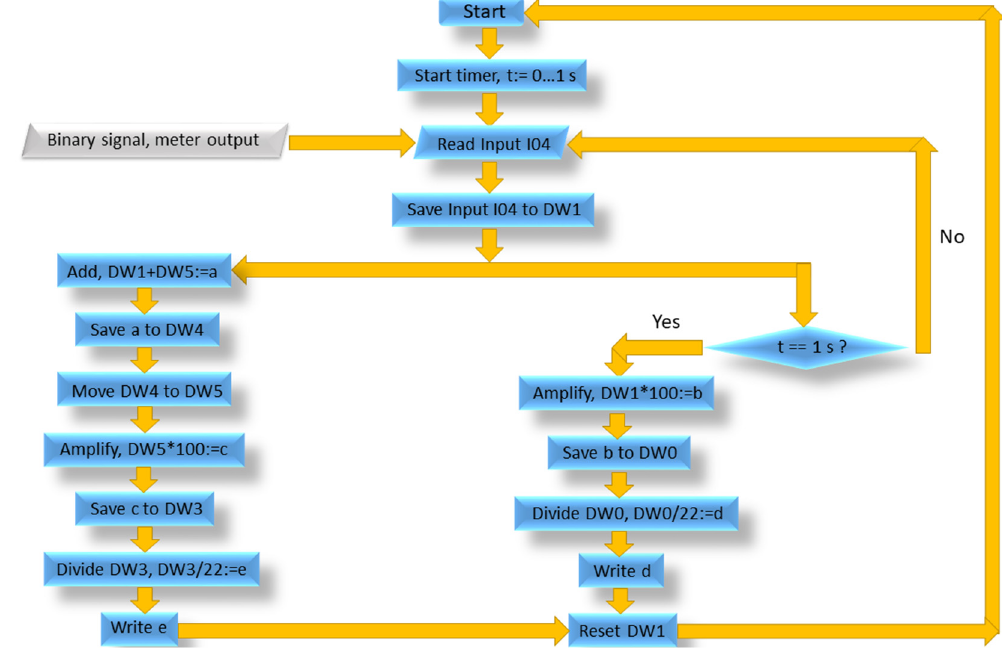
Figure 3. Algorithm for PLC firmware.